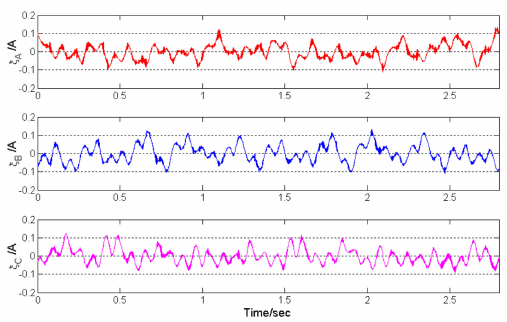
Figure 18. Harmonic currents of proposed method.